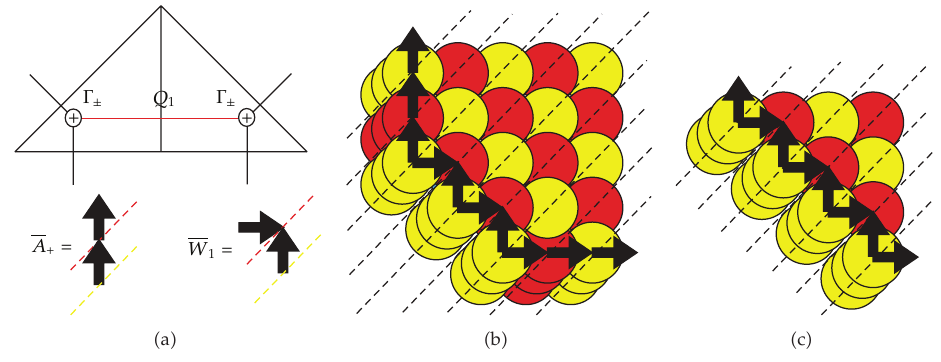
Figure 11: Toric diagram for the resolution of C 3 / Z N (cid:9) 1 geometry has N (cid:9) 1 vertices of the same type ⊕ . (cid:4) a (cid:5) : toric diagram for N (cid:7) 1 and arrow representation of A (cid:9) and W 1 . In the noncommutative chamber, this leads to the same plane partition crystal as in Figure 10, however colored now in yellow and red. (cid:4) b (cid:5) : for the chamber with positive R and 2 < B < 3, the crystal develops two additional corners and its generating function reads Z 2 | 1 (cid:7) (cid:18) Ω (cid:9) | (cid:4) W 1 (cid:5) 2 | Ω − (cid:15) . (cid:4) c (cid:5) : for negative R and positive n − 1 < B < n the crystal is finite along two axes and develops n − 1 yellow corners; its generating function for the case of n (cid:7) 5 shown in (cid:10) the picture reads Z 5 | 1 (cid:7) (cid:18) 0 | (cid:4) W 1 (cid:5) 5 | 0 (cid:15) (cid:4) two external arrows, corresponding to Γ − acting on (cid:18) 0 | and Γ (cid:9) acting on | 0 (cid:15) , are suppressed. (cid:5)